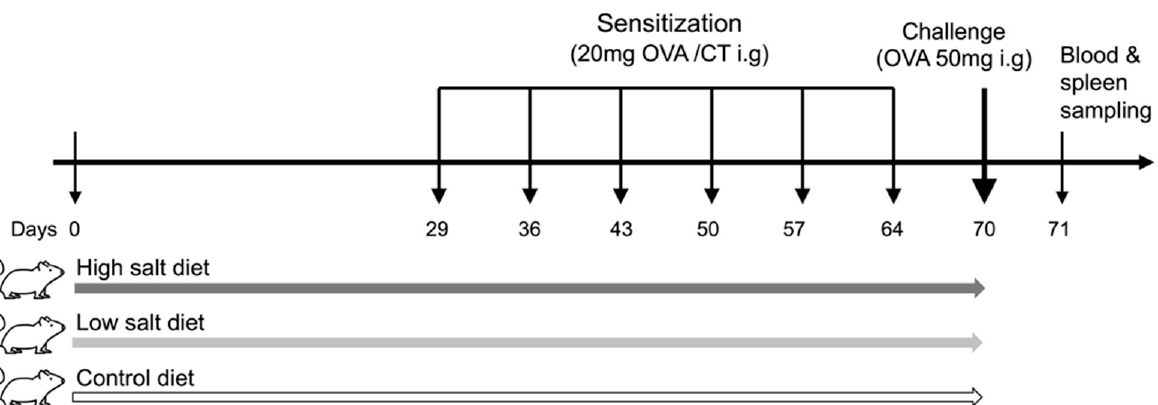
Figure 1. Experimental protocol. Three different experimental protocols were used for priming. Mice were fed a high- or low-salt diet or control diet ad libitum for 10 weeks. After 4 weeks of exposure to different sodium concentrations, all mice were intragastrically sensitized with 20 mg of ovalbumin (OVA) and 10 µ g of cholera toxin (CT) once every week, for six weeks. After sensitization, mice were challenged with 50 mg of OVA via intragastric gavage. All mice were euthanized for blood and spleen sampling 1 day after the OVA challenges. Ovalbumin: OVA, cholera toxin: CT, intragastrically: i.g.